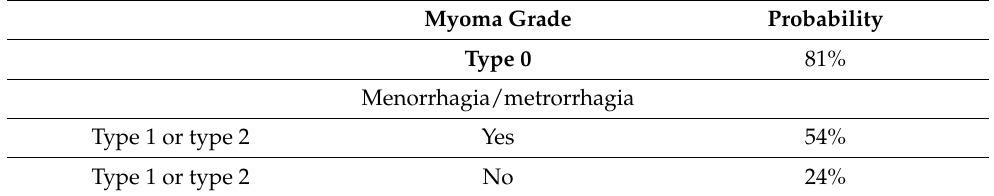
Table 4. Probability of anemia related to myoma grade and menorrhagia.